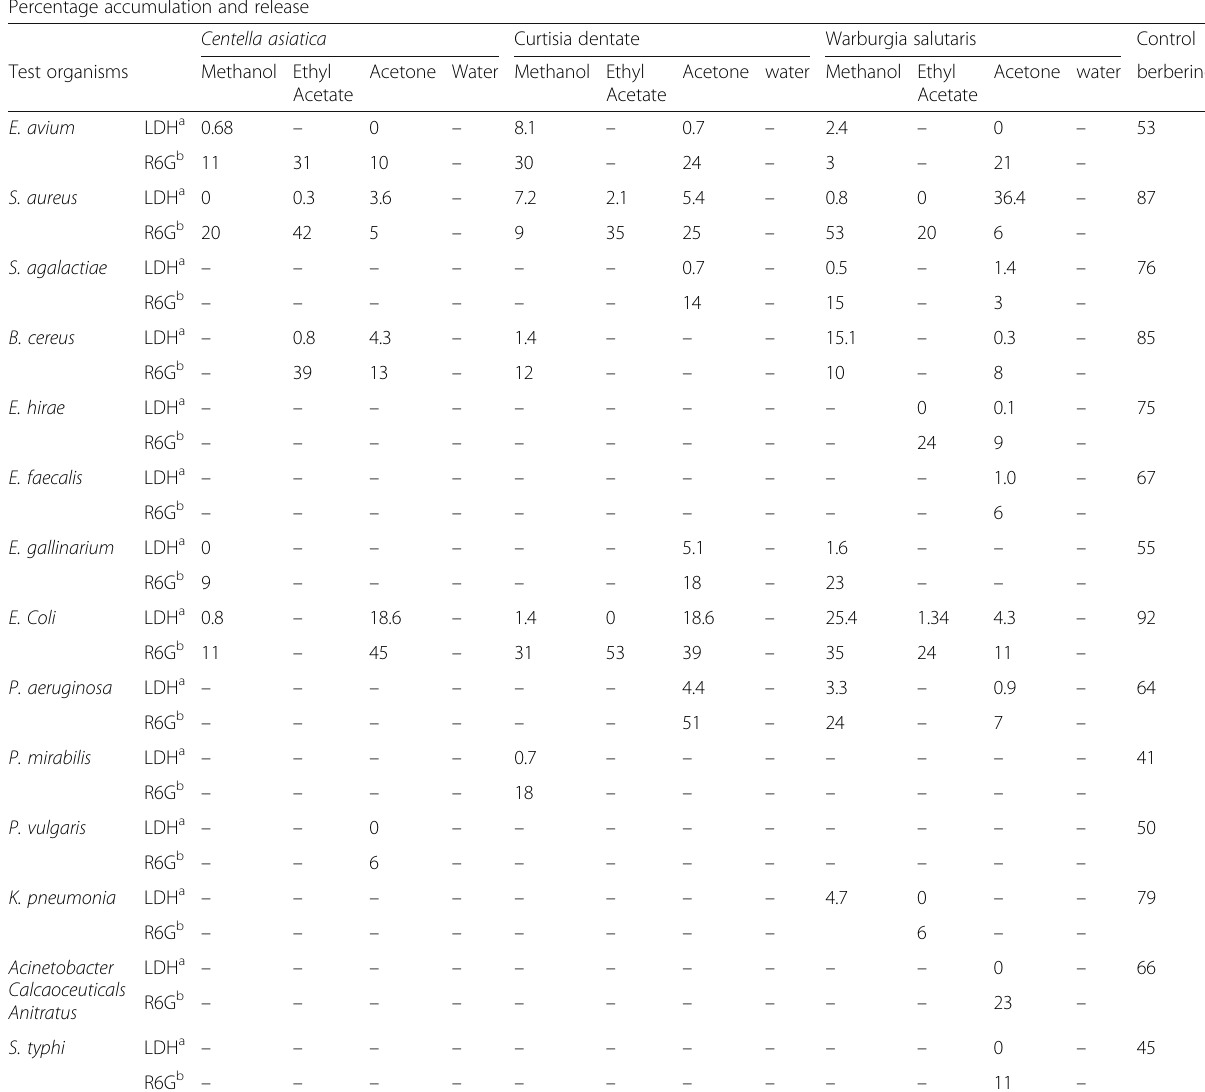
Table 3 Antibacterial percentage cytosolic lactate dehydrogenase assay and percentage accumulation of R6G inside the cell after exposure to glucose, plant extract and standard inhibitor bererine Percentage accumulation and